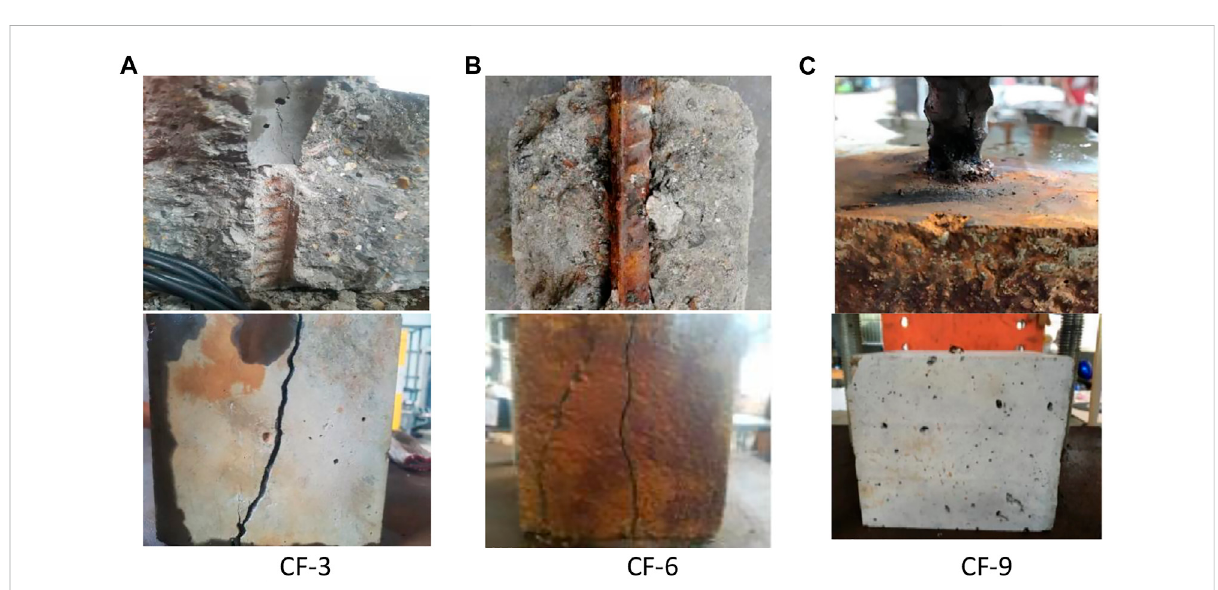
FIGURE 7 Failure mode of the combined action